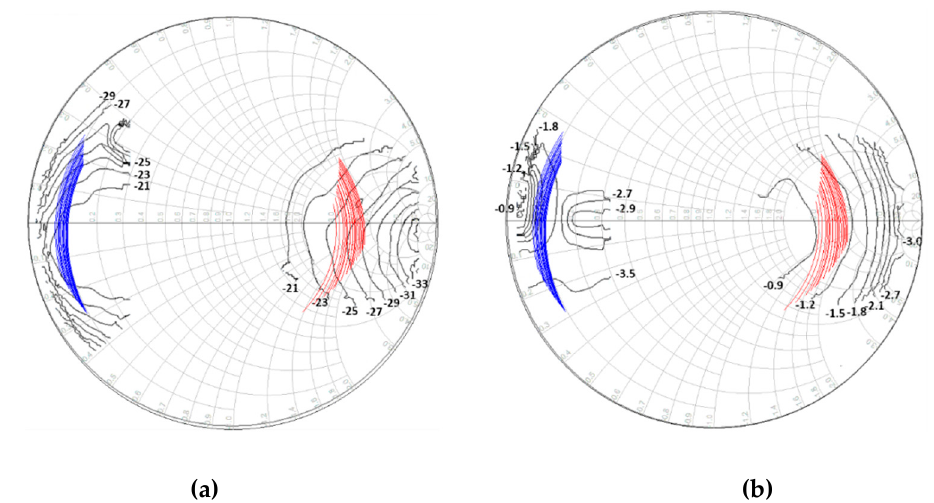
Figure 9. The effect of combination for the variations in both the radius (R) and the angular span ( θ ) presented as impedance trajectories on the Smith Chart with corresponding performance contours of ( a ) the insertion loss, and ( b ) the isolation level for frequency ranging from 30 GHz to 40 GHz.